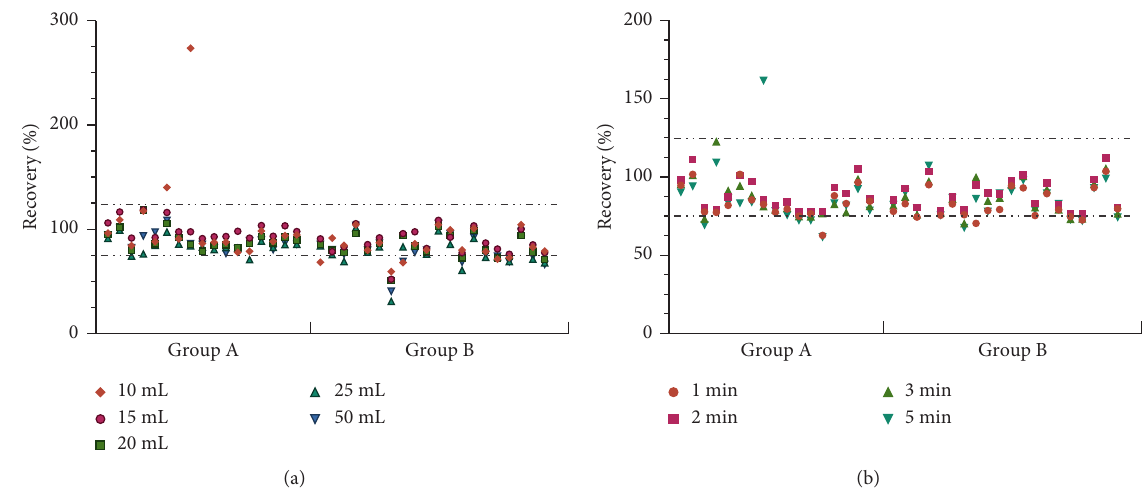
Figure 4: Effect of solvent volume (a) and grinding time (b) on